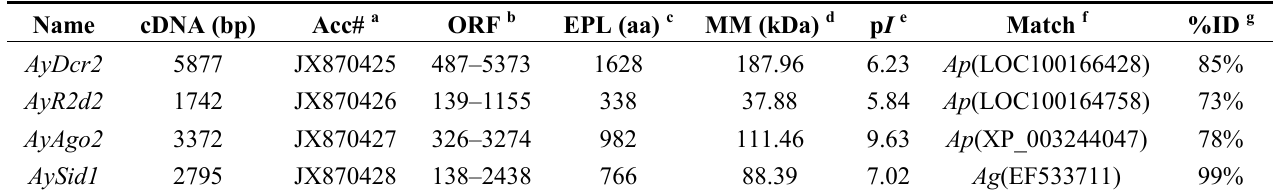
Table 1. Description of Dcr2 , R2d2 , Ago2 , and Sid1 cDNAs in A. glycines